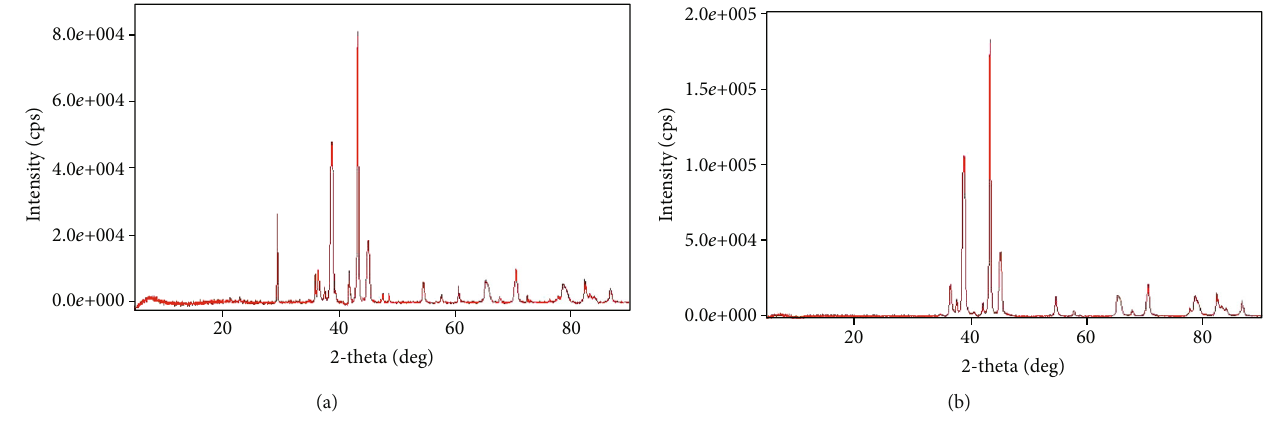
Figure 5: XRD pattern for (a) unused ACMAS and (b) CV-loaded